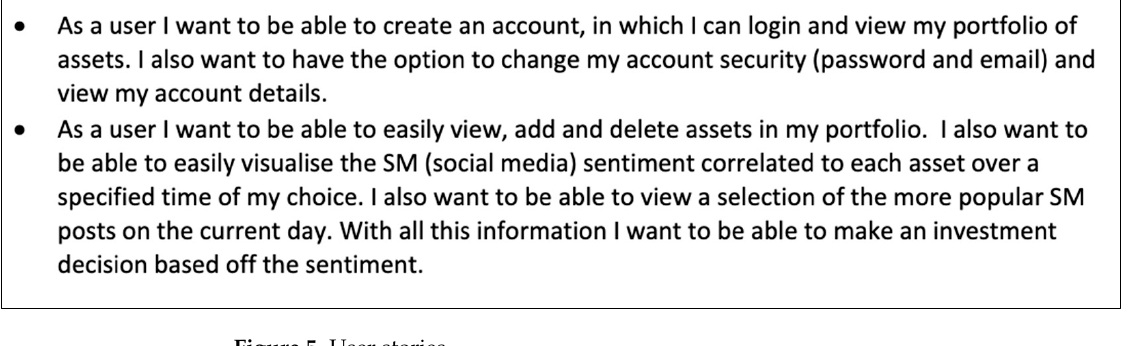
Figure 5. User stories.